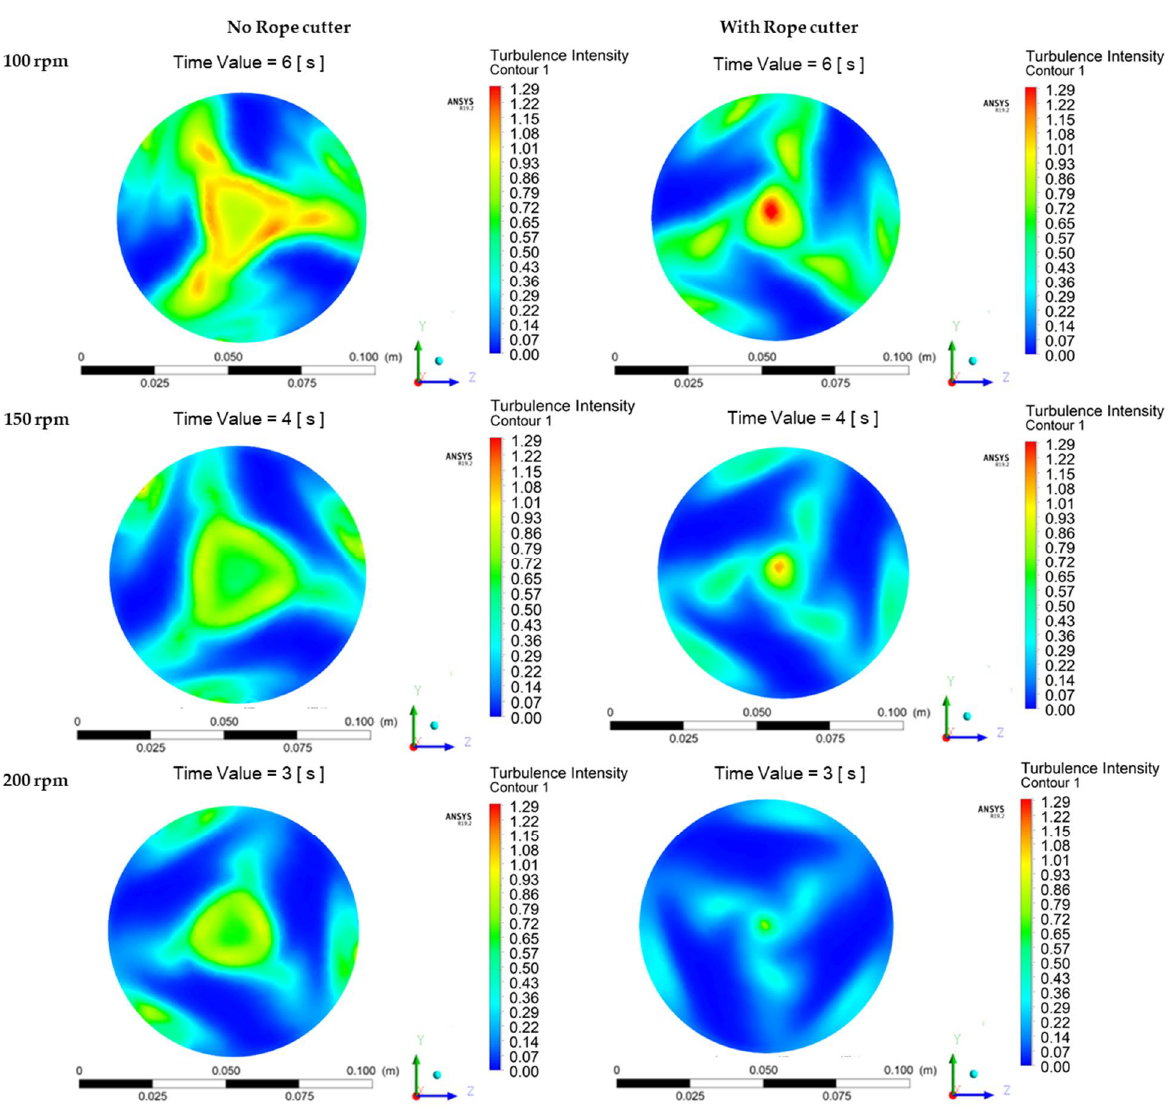
Figure 20. Turbulence intensity color maps on the transverse plane behind the propeller [%].